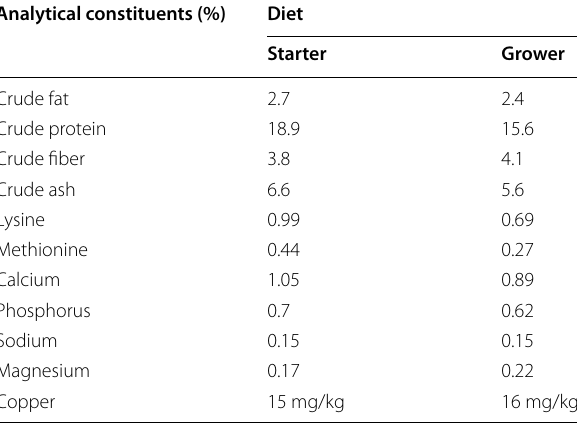
Table 1 Composition of Starter and Grower diets fed to birds ad libitum throughout each